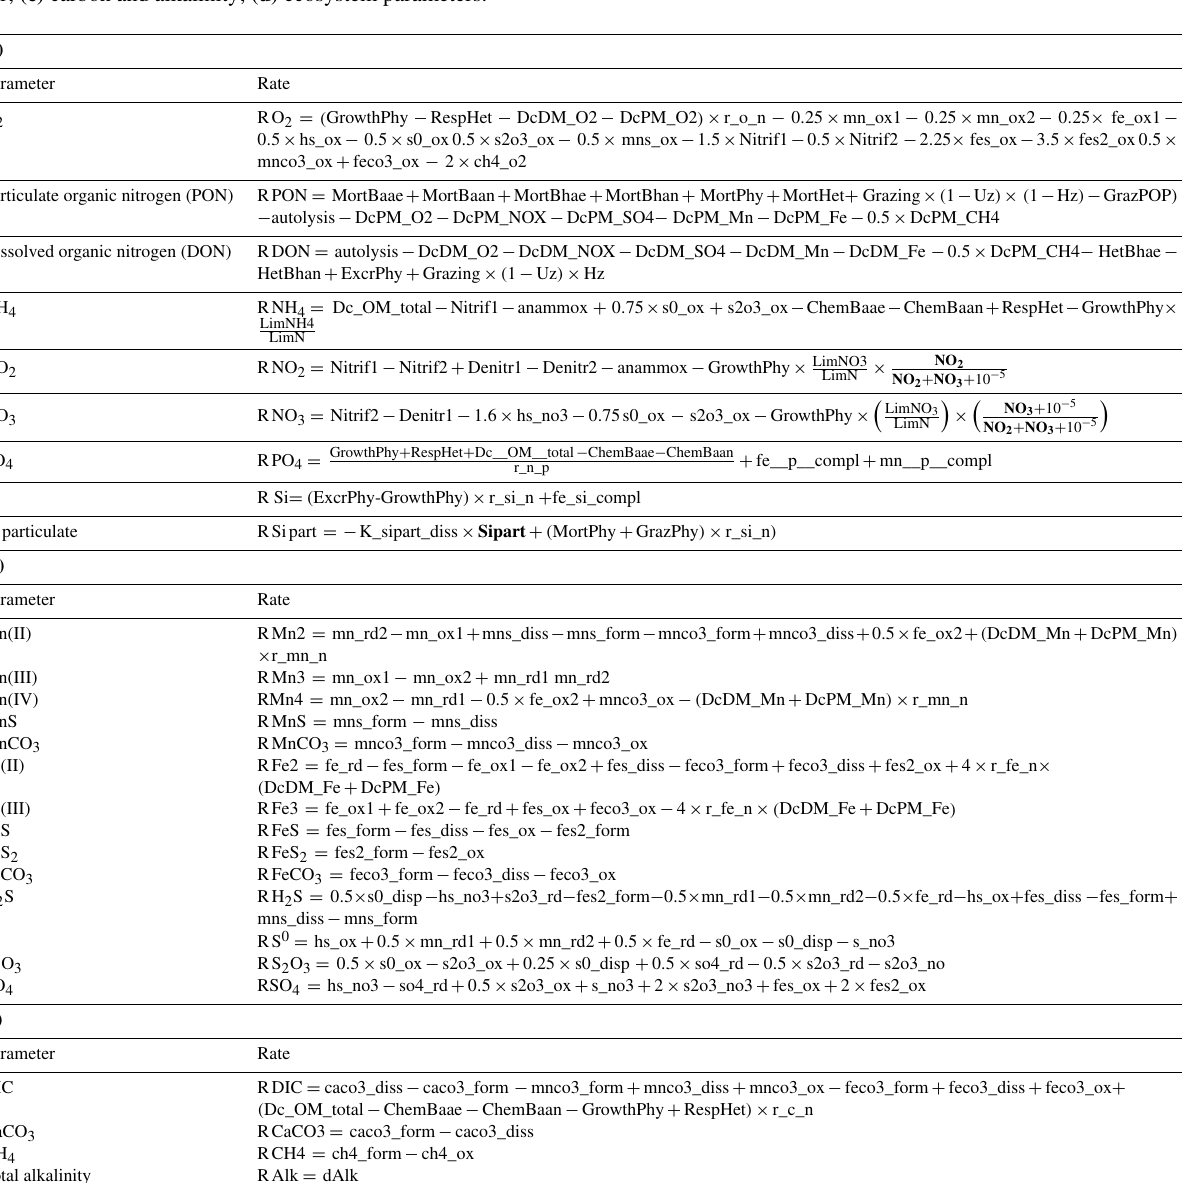
Table 4. Rates of biogeochemical production/consumption of the model compartments: (a) nutrients and oxygen; (b) Redox metals and sulfur; (c) carbon and alkalinity; (d) ecosystem